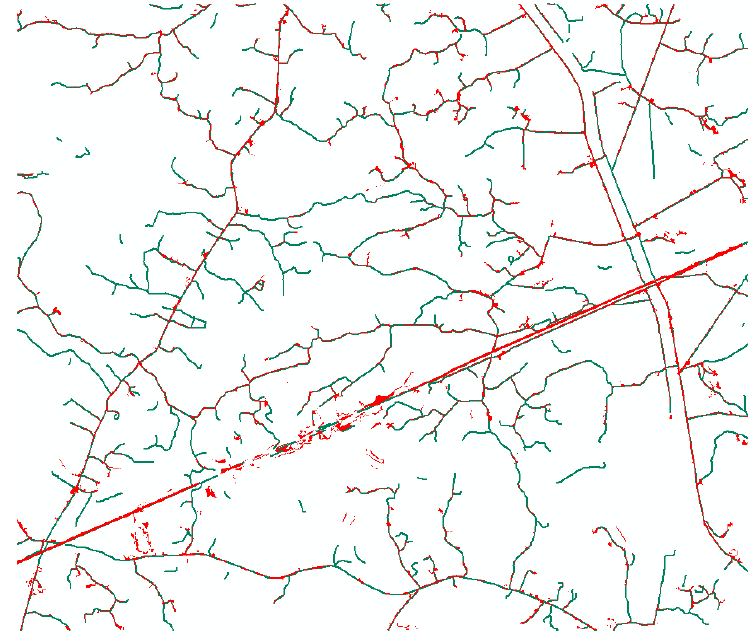
Figure 17. Overlap of the GFI result (green) and the OOC result (red).